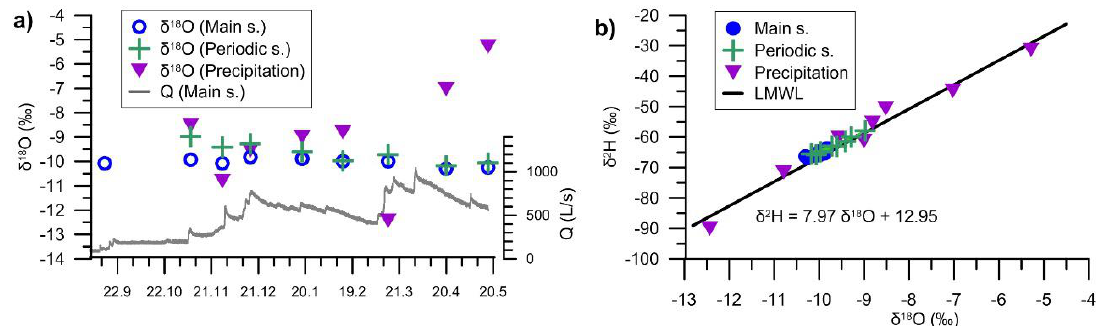
Figure 9. Stable isotope composition of the springs water and local precipitation: ( a ) Changes of δ 18 O in time and hydrograph of the main spring (Q); ( b ) Composition of δ 2 H and δ 18 O in all samples, and the local meteoric water line (LMWL) resulting from the bulk precipitation compositions.